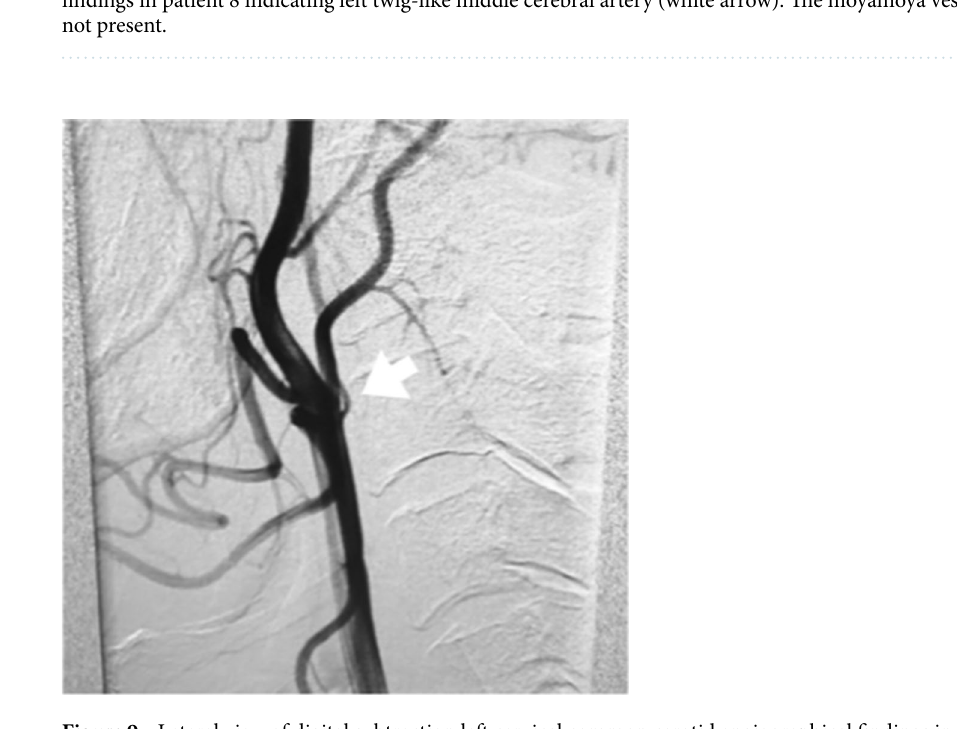
Figure 9. Lateral view of digital subtraction left cervical common carotid angiographical findings in patient 9 indicating aplasia of the left internal carotid artery (white